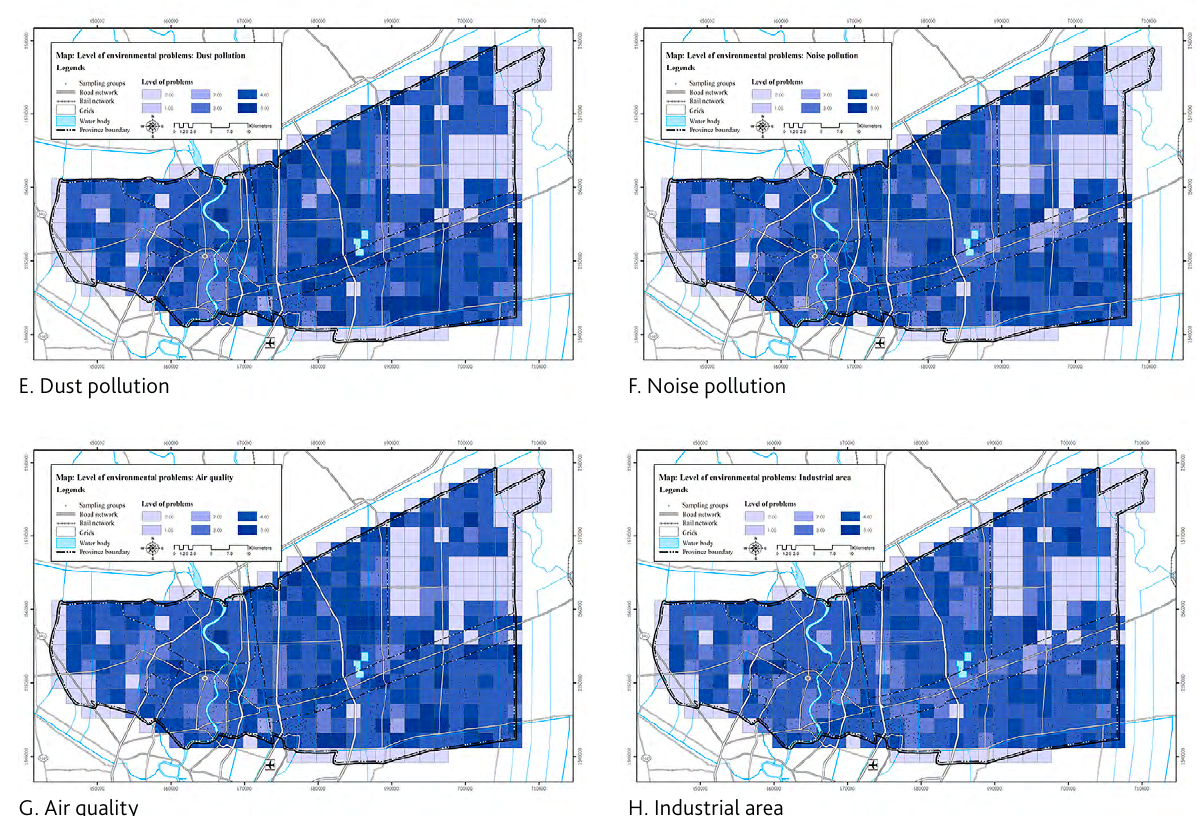
Figure 4. Average score of different built environment factor (continued from the previous